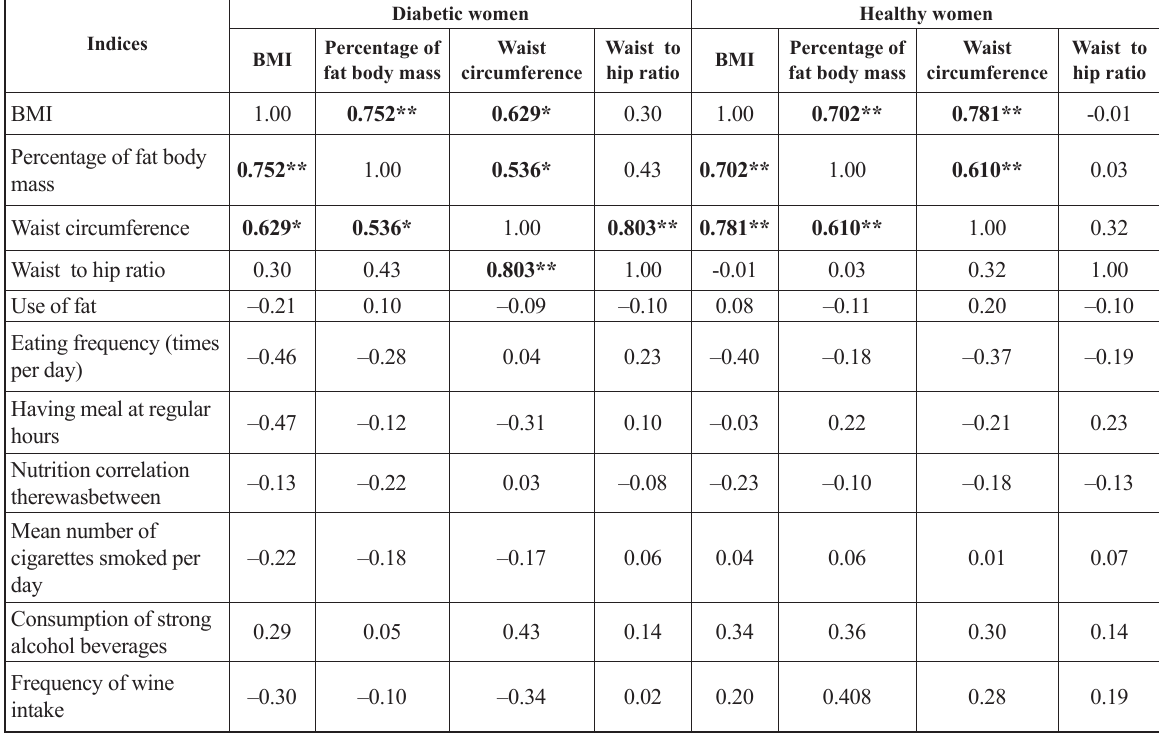
Table. Interplay between anthropometric parameters and the data of the questionnaire for diabetic and healthy women by Pearson’s correlation coefficient